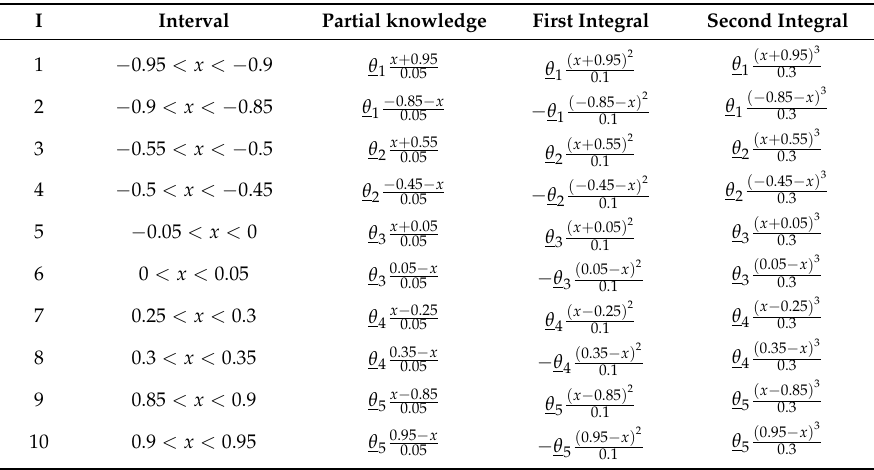
Table 5. Lower MF